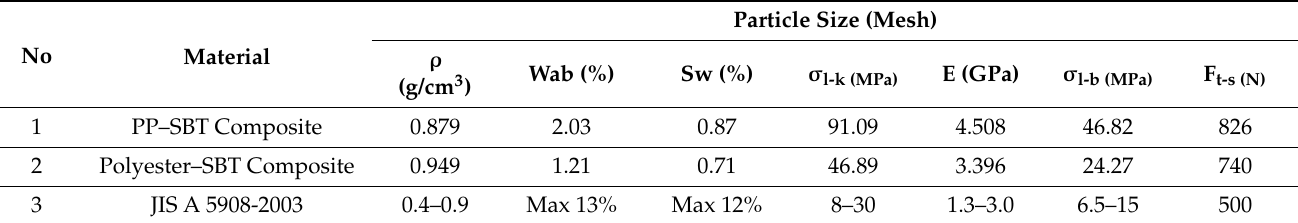
Table 2. Testing and characteristic results for